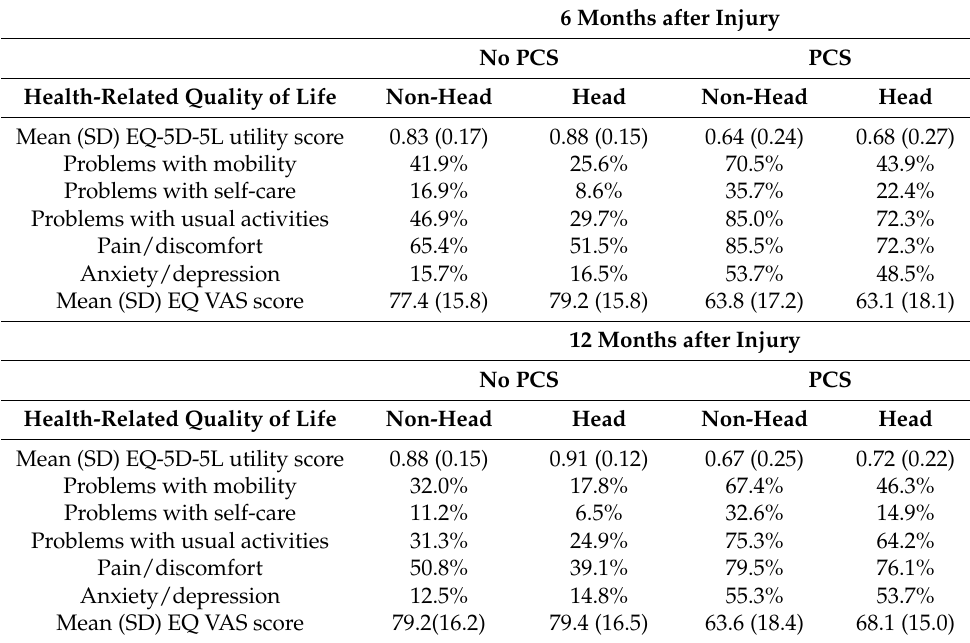
Table A2. Mean T1 and T2 EQ-5D-5L utility and EQ VAS scores and percentage of patients reporting problems on EQ-5D-5L dimensions, for patients with and without post-concussion syndrome (PCS) and with and without head